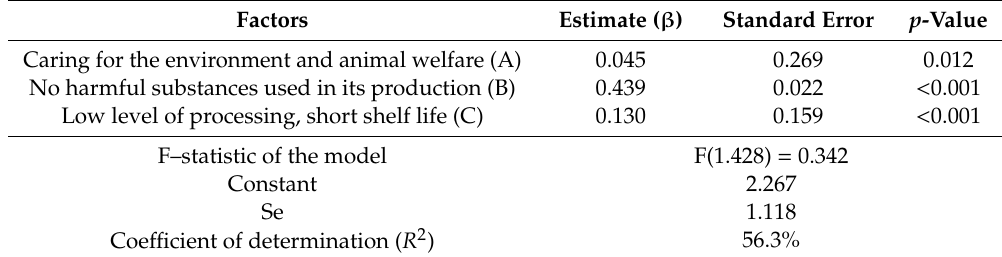
Table 5. Linear regression analysis for the variables describing the relationship between the pro-environment awareness and the tendency to purchase legume products. Factors p